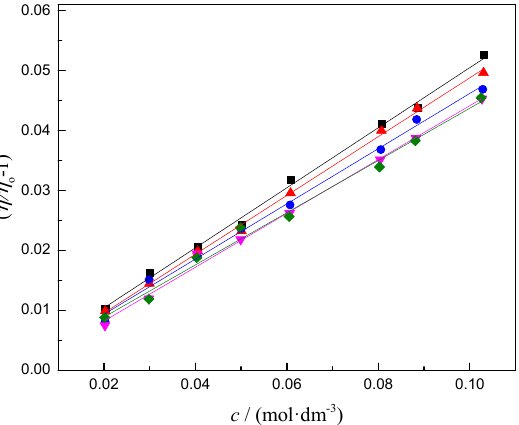
Figure 5. Plot of reduced viscosity ( η / η o − 1) versus concentration ( c ) of the caffeine in SS aqueous solutions, at different temperatures, T = ( ) 293.15, ( ▲ ) 298.15, ( ) 303.15, ( ) 308.15, and ( ◆ ) 313.15 K.